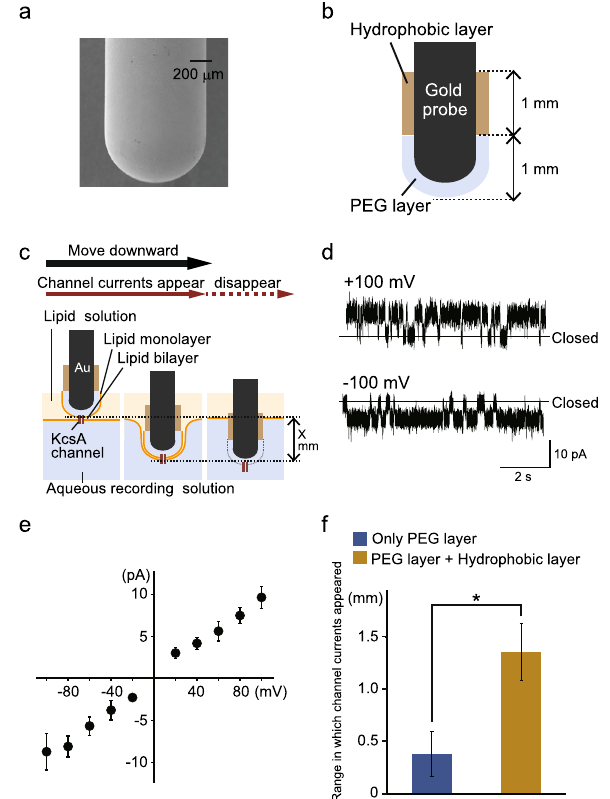
Figure 3. Effect of hydrophobically modifying the gold probe on the stability of the lipid bilayer membrane. (a) Electron micrograph of the tip of a commercially available gold probe. (b) Schematic depiction of a probe whose tip was modified so as to have a hydrophobic 1-octadecanethiol layer beside a hydrophilic polyethylene glycol (PEG) layer. (c) Procedure to investigate the stability of the lipid bilayer membrane. The bilayer membrane containing KcsA channels (KcsA(E71A)) was made at the interface between a lipid solution and an aqueous recording solution; formation of the membrane was detected by appearance of channel currents (left). The probe was then moved downward in 10-µm increments (middle), until the channel currents disappeared (right), so that the range in which the channel currents were detectable was recorded. (d) Representative current traces of KcsA(E71A) channels recorded in the lipid bilayer membrane consisting of POPE–POPG and n -decane at ± 100 mV. (e) Current–voltage relationship recorded for KcsA(E71A) channels (n = 7). (f) Length ranges wherein channel currents were detected using the POPE–POPG lipids dissolved in n -decane. The ranges were wider when gold probes comprising the hydrophobic layer were used. Range differences were analyzed using Welch’s t-test. The bar indicates the mean standard deviation (n = 6–7). The asterisk indicates that P < 0.01. POPE 1-palmitoyl-2-oleoyl-sn-glycero-3-phosphoethanolamine; POPG 1-palmitoyl-2-oleoyl-sn-glycero-3-[phospho- rac-(1-glycerol)]; POPE–POPG lipid solution consisting of 18 mg/ml POPE and 6 mg/ml